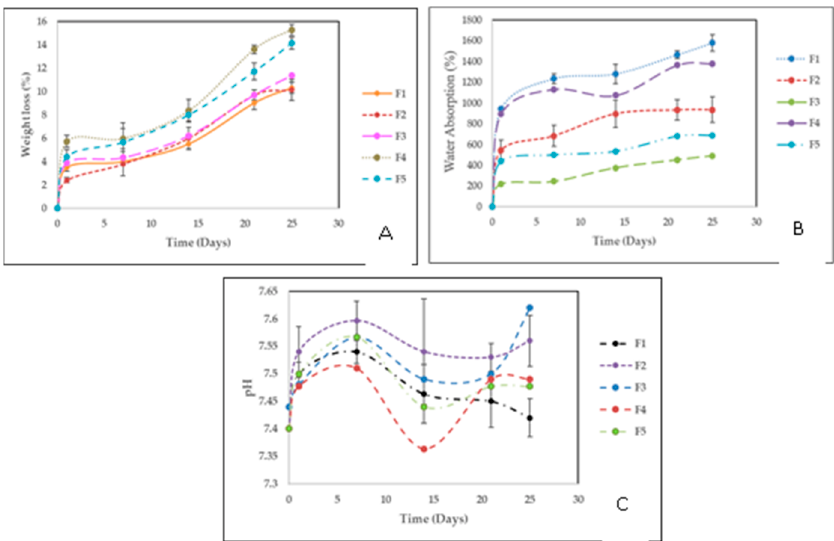
Figure 9. ( A ) Weight loss vs. immersion time in a simulated biological fluid (SBF) of the films. ( B ) Water absorption vs. immersion time in a simulated biological fluid (SBF) of the films. ( C ) Study of the solution pH vs. immersion time in a simulated biological fluid (SBF) of the films. Formulations: F1